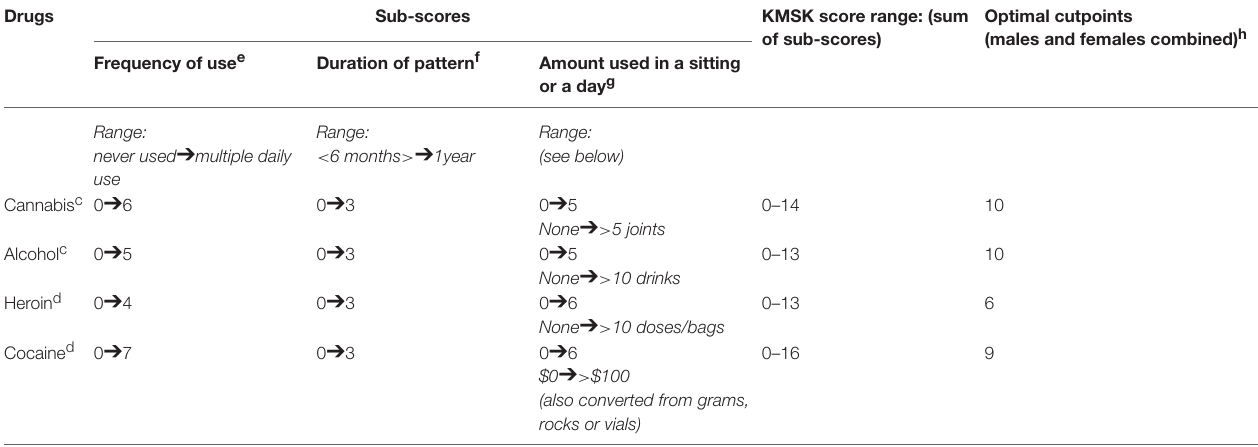
TABLE 2 | KMSK scales for maximal self-exposure to specific drugs a,b . Drugs Sub-scores KMSK score range: (sum Frequency of use e Duration of pattern f Amount used in a sitting